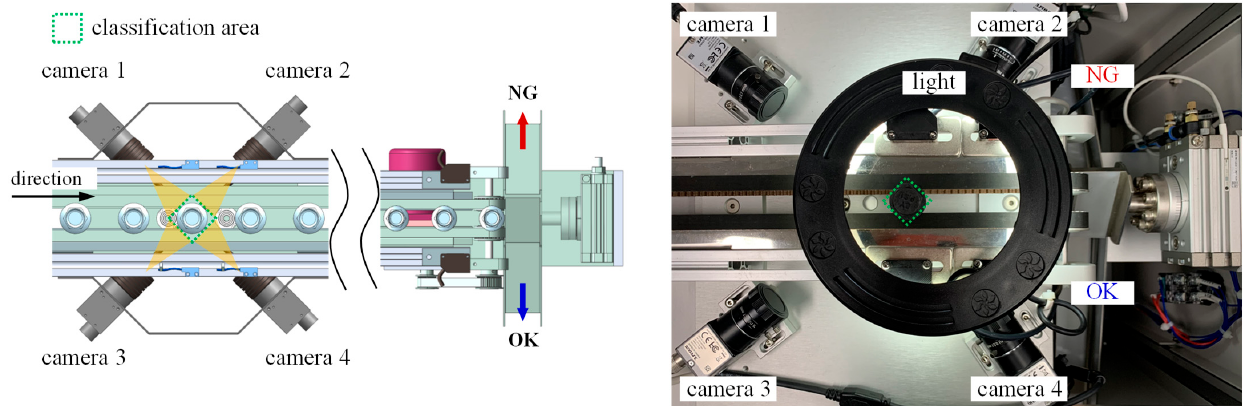
Figure 8. System for inspecting bolt coating defects and sorting. NG, defective; OK, non-defective.